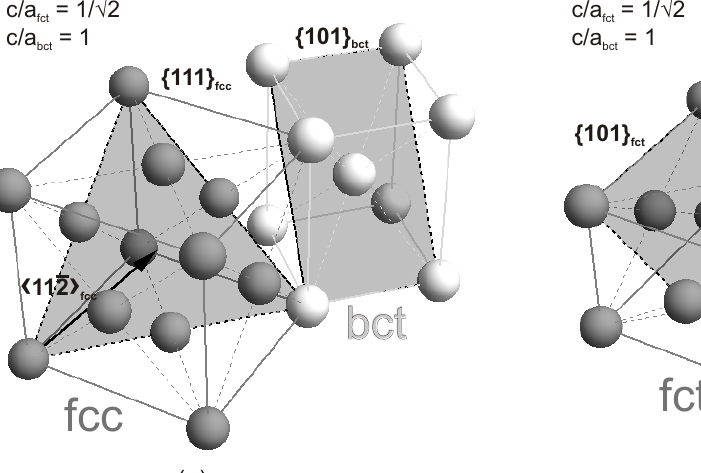
Figure 1. Scheme of the elementary twin reactions along the Bain path: ( a ) fcc (face- centered cubic) system (dark grey atoms) with { 111 } cubic) system (bright grey atoms) with { 112 } planes are shaded in